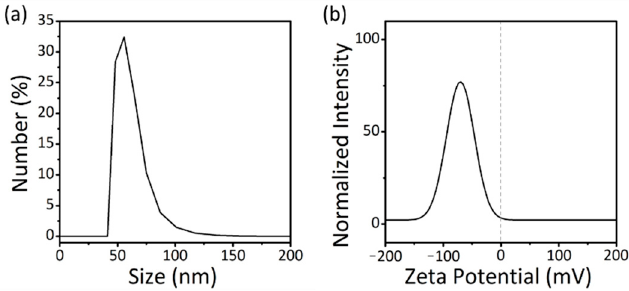
Figure 2. ( a ) Dynamic light scattering (DLS) and ( b ) ζ -potential measurements of n-octade- cane/PMMA nanobeads. PMMA